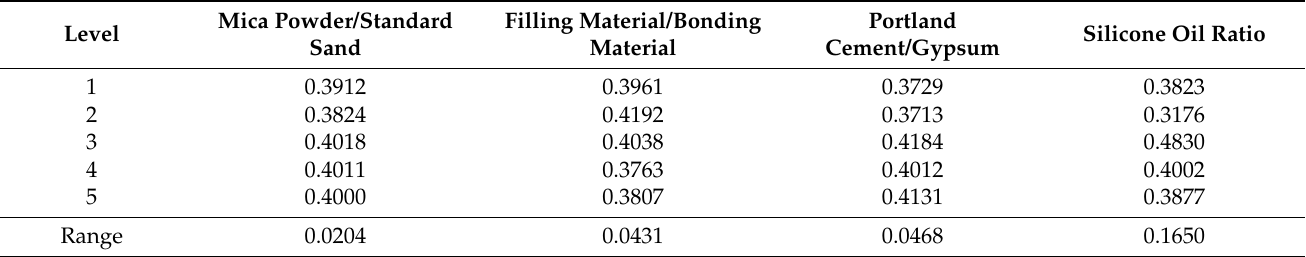
Table 8. Range analysis of elastic modulus